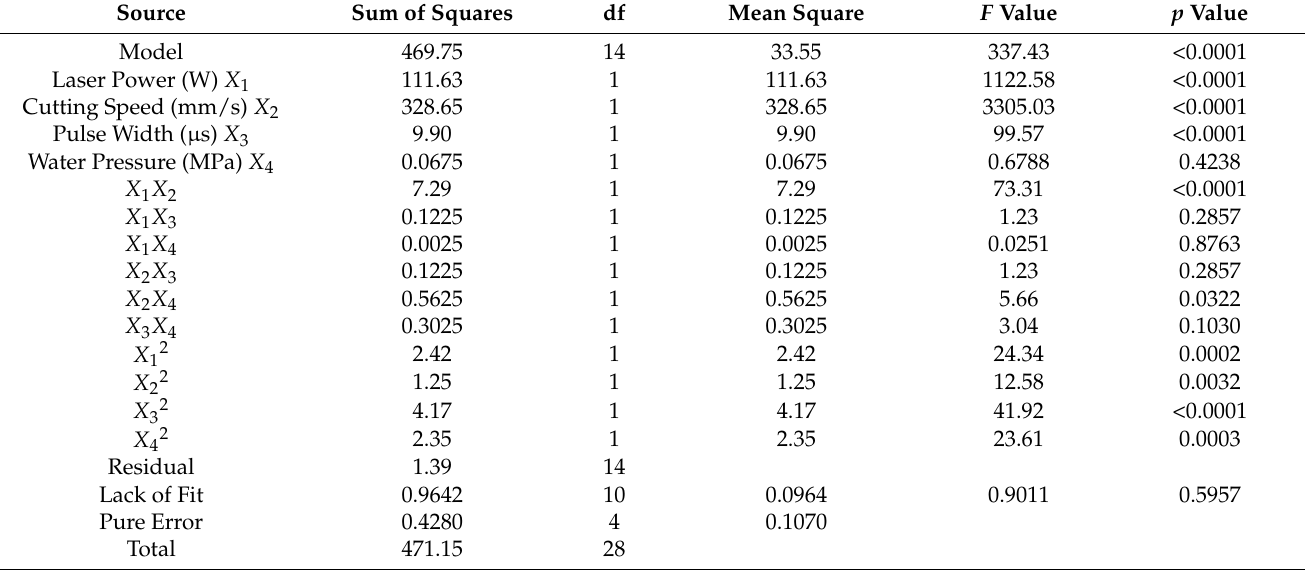
Table 10. ANOVA of the regression model for MRR.